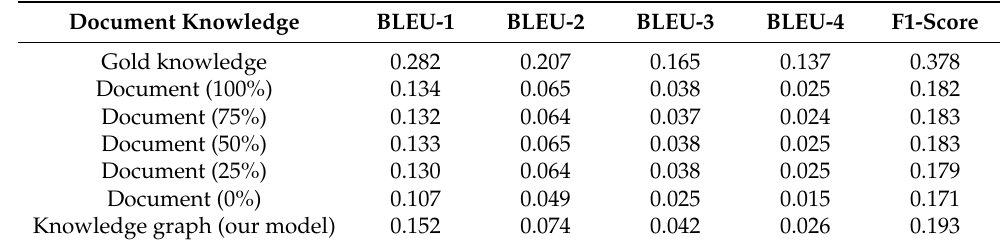
Table 4. Performance comparison according to knowledge input on the Wizard-of-Wikipedia